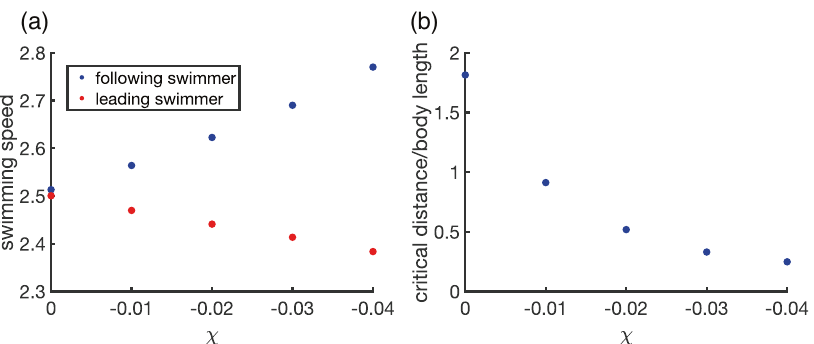
Fig. 9 Swimming speed for two swimmers, one following the other. Two pushers ( β = − 2) with planar anchoring ( W = 0.5) swim one after the other. The initial distance from the tail of the leading swimmer to the head of the following swimmer is twice their body length. a The average speed of each pusher swimming its fi rst body length b Critical distance (measured from the tail of the leading swimmer to the head of the following swimmer) between two swimmers when their speeds become